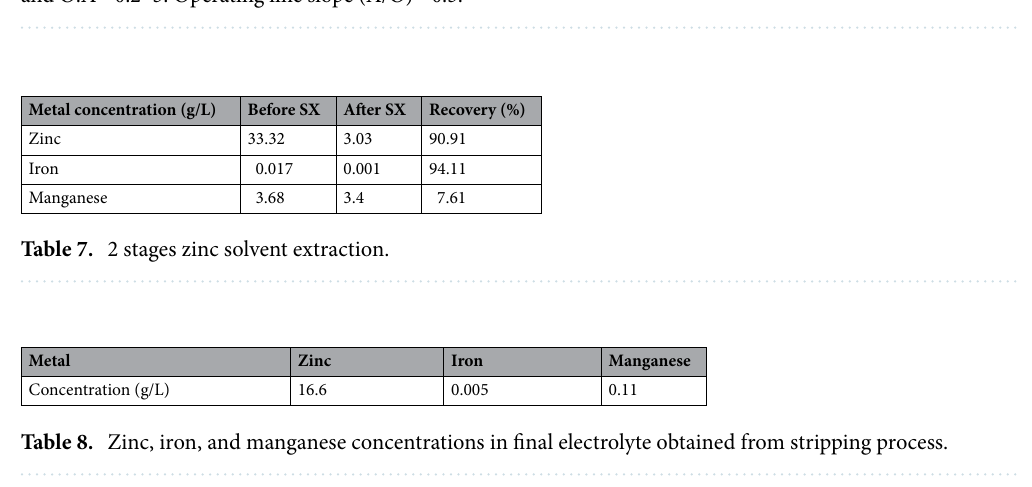
Figure 7. McCabe–Thiele plot of the extraction of zinc with 33% (v/v) D2EHPA. Extraction isotherm, pH = 2.5 and O:A = 0.2–5. Operating line slope (A/O) = 0.5.